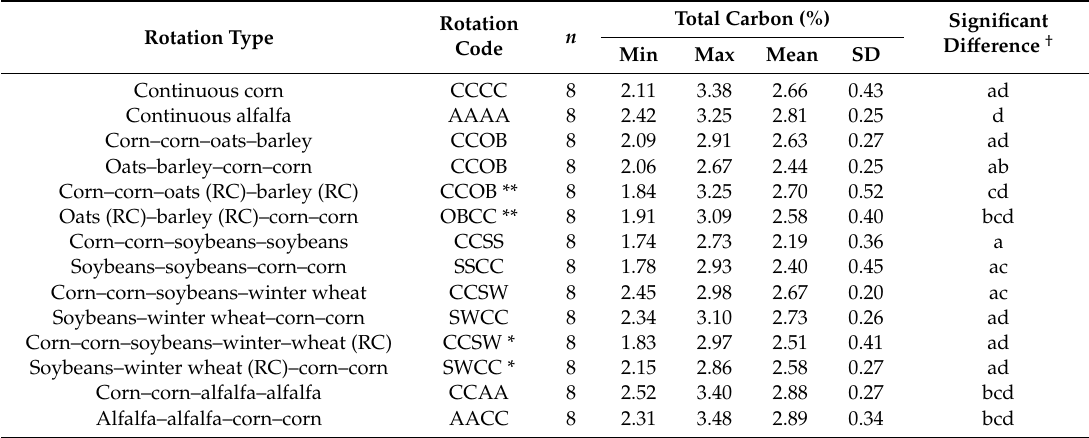
Table 1. Description of codes used to represent crop rotation type for the study and descriptive statistics of total carbon (TC) data collected in